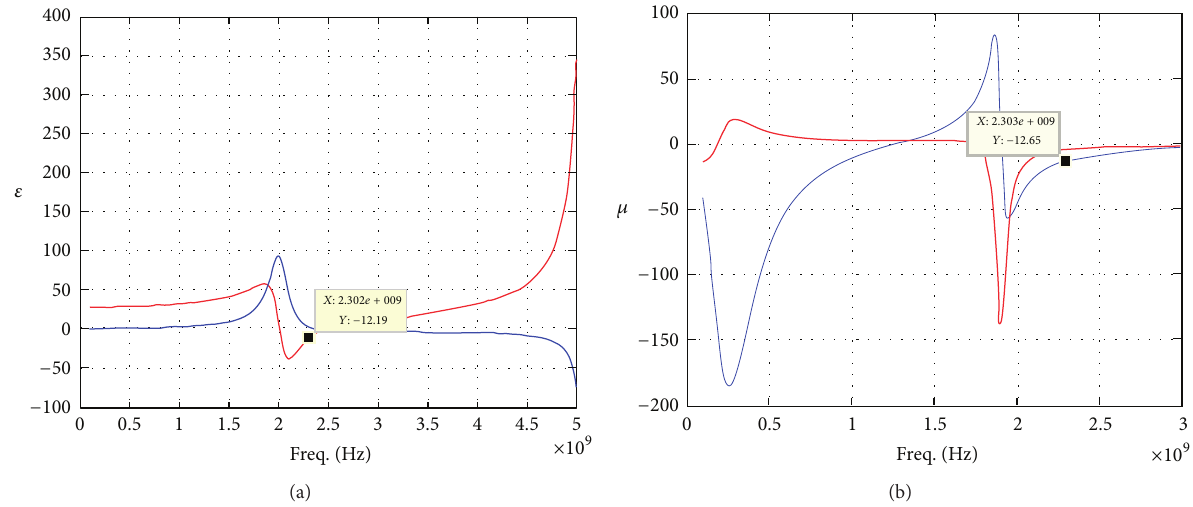
Figure 4: The variation of the real (red) and imaginary part (blue) of the permittivity ( 𝜀 ) and the variation of the real (red) and imaginary part (blue) of the permeability ( 𝜇 ) according to the frequency.